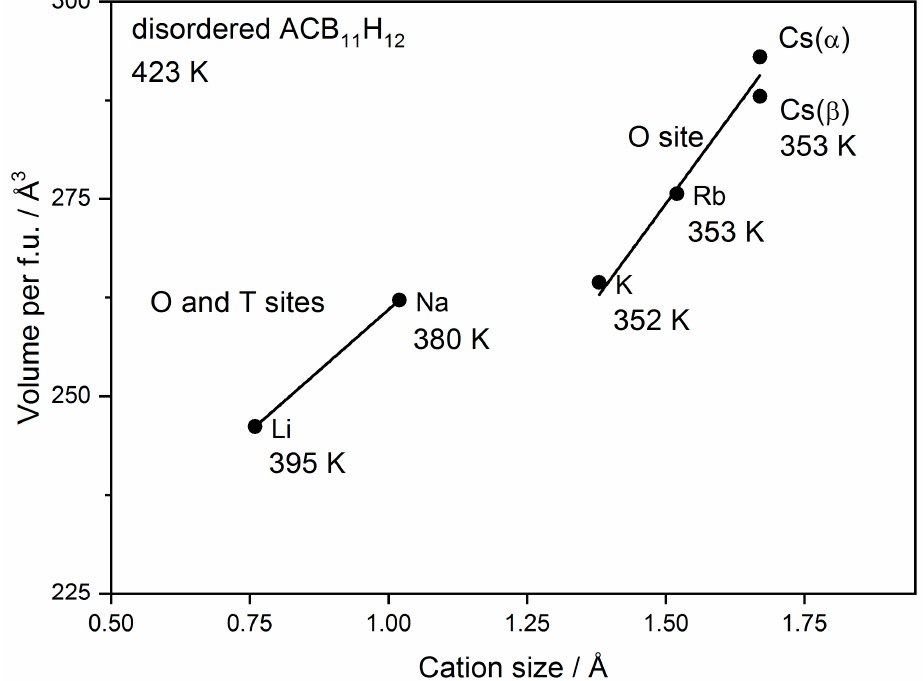
Figure 5. Dependence of volume per formula unit in ACB 11 H 12 (A = Li, Na, K, Rb, and Cs) on alkali cation radius in octahedral coordination according to Shannon [23]. The temperature of cation- and anion-disordering is also given. The structure of all compounds is disordered with ccp or hcp anion packing with the exception of disordered β -CsCB 11 H 12